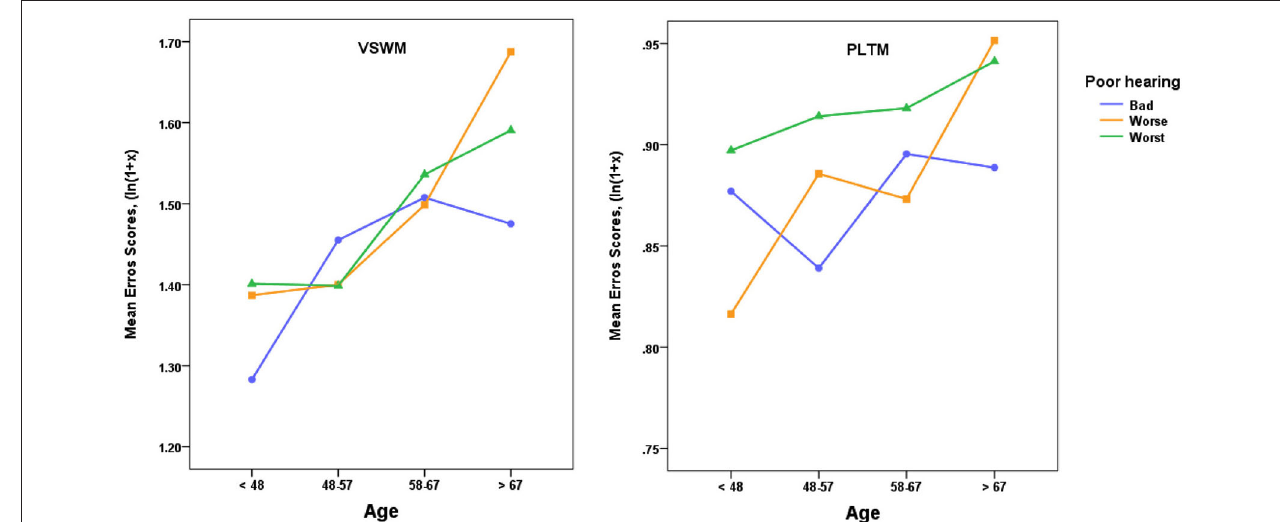
PLTM = The prospective memory task. For VSWM there was only a significant effect of Age (see text) and for PLTM there was a significant difference between the Bad and Worst groups, one-tailed t ( 789 ) = 1.78, p <